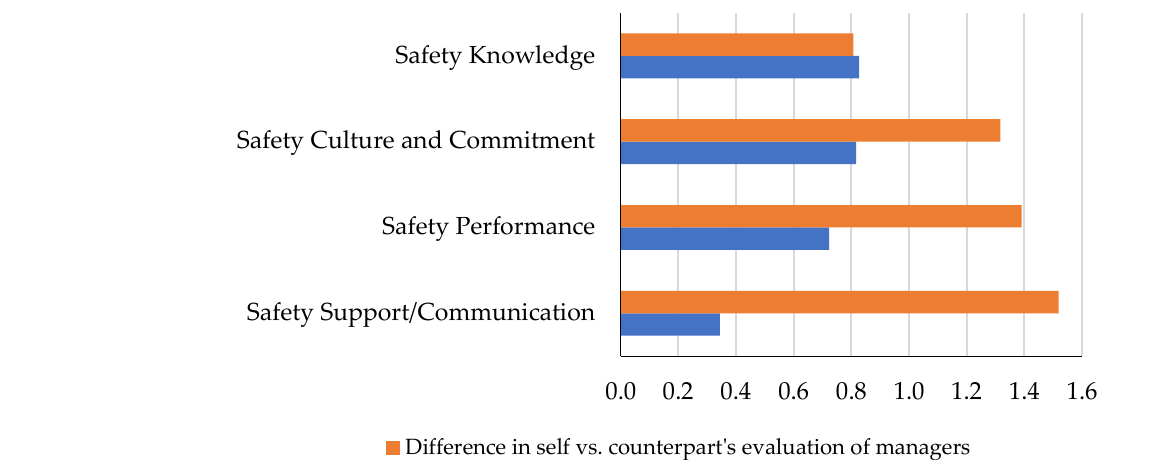
Figure 6. Differences in self vs. counterparts’ evaluation of managers and workers. Table 6. Results of comparing managers’ self-assessment with workers’ assessment of managers. Comparison Category